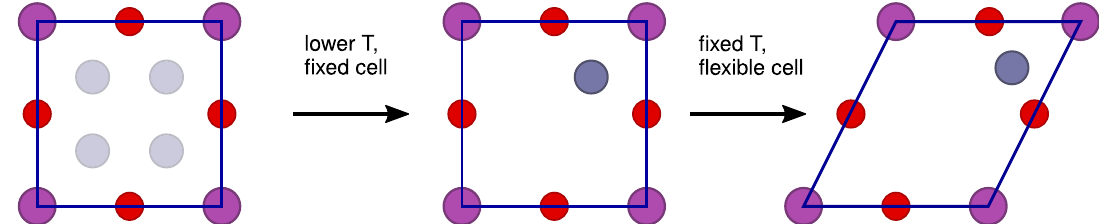
Fig. 4 Schematic of the ferroelectric transition. 2D sketch of the sequence of events marking the onset of a ferroelectric state starting from a perfect cubic con fi guration.